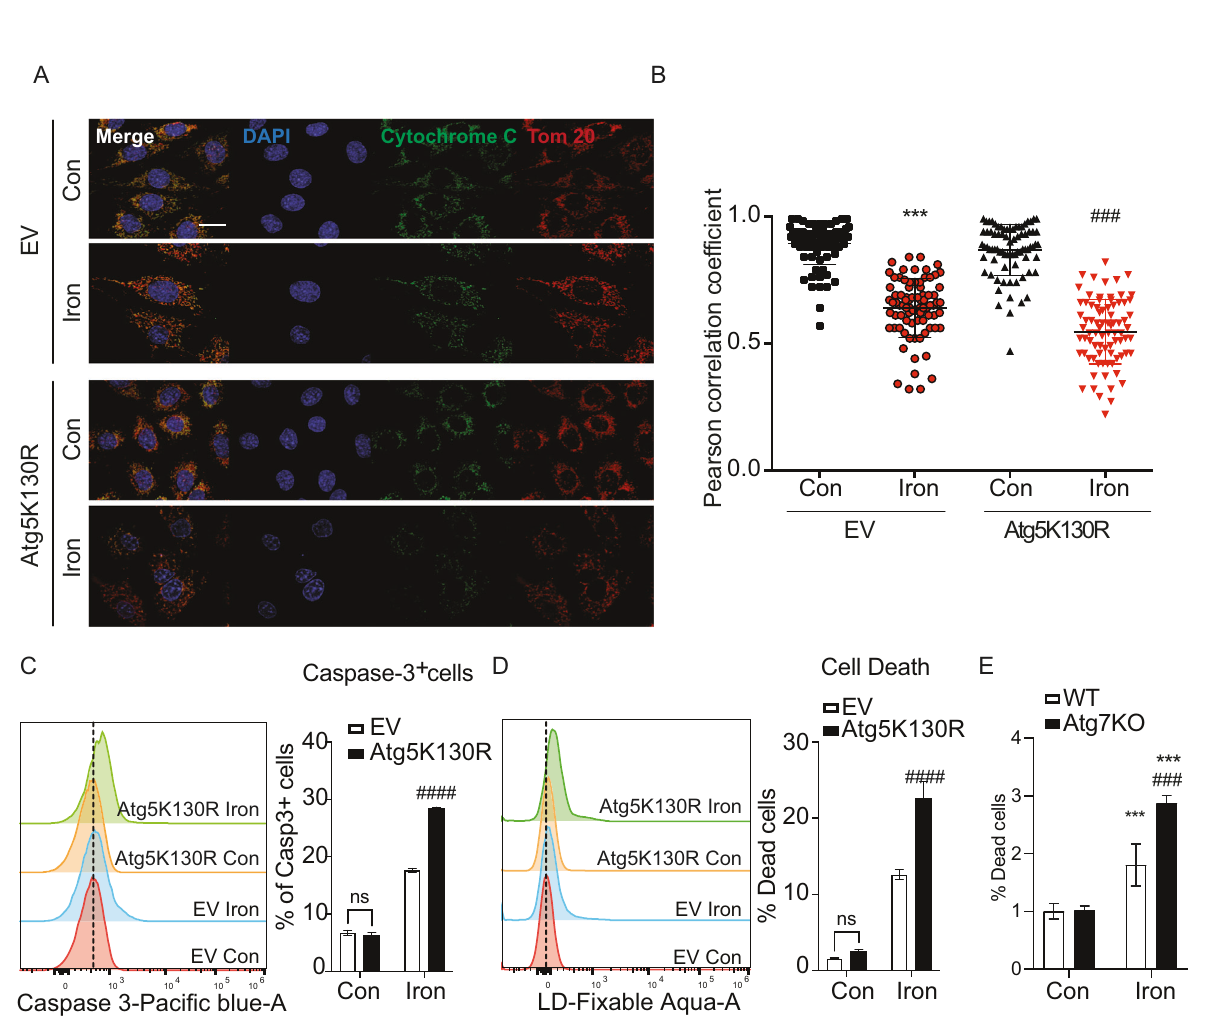
Fig. 6 Iron-induced apoptosis is enhanced in autophagy-de fi cient cells. A Representative immuno fl uorescence images showing cytochrome c (green), Tom-20/mitochondria (red), nucleus (blue) in EV or Atg5K130R cells treated with 250 μM FeCl 3 for 24 h. Colocalization of red/green was quanti fi ed and shown in B as Pearson ’ s correlation coef fi cient ( n = 3). C Overlayed histograms (left panel) showing the mean fl uorescence intensity (MFI) of Caspase-3 in EV and Atg5K130R cells cells upon treating with 250 μM FeCl 3 for 24 h (Iron), while the graphs (right panel) showing the average of Caspase-3 + cells from three experiments. D Overlayed histograms (left panel) showing the MFI dead cells in EV and Atg5K130R cells as in C , while the graphs (right panel) show MFI of dead cells from three experiments ( n = 3). LDH release detection assay for cell death, quanti fi ed as 490 nm absorbance in WT and Atg7KO cells E ( n = 3). Scale bar denotes 20 μm. All graphs show mean ± SEM and * = P < 0.05, ** = P < 0.01, *** = P < 0.001 versus control, # = P < 0.05, ## = P < 0.01, ### = P < 0.001 versus WT iron. this study was that iron had exaggerated effects on ROS production and cell death in autophagy de fi cient cells generated autophagy fl ux and thus leads to enhanced cell death after either by overexpressing the dominant-negative Atg5K mutant or by CRISPR-mediated deletion of Atg7. In summary, our data indicates that iron-induced ROS produc- tion plays a critical role in the induction of mitochondrial- dependent apoptotic cell death. Whereas the cell responds to this Cell Death and Disease (2023)